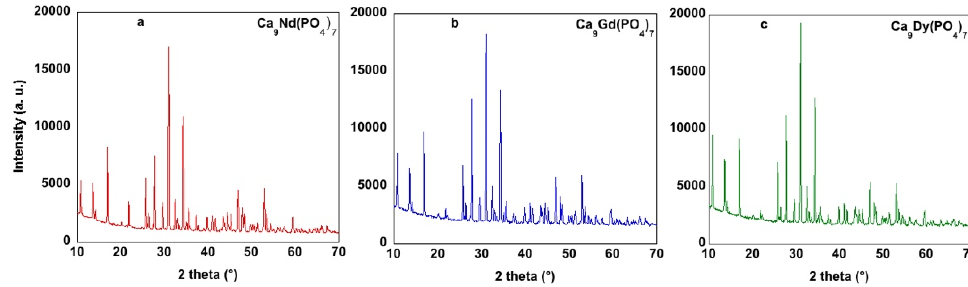
Figure 1. Powder X-ray spectra of Ca 9 Nd(PO 4 ) 7 ( a ), Ca 9 Gd(PO 4 ) 7 ( b ), and Ca 9 Dy(PO 4 ) 7 ( c